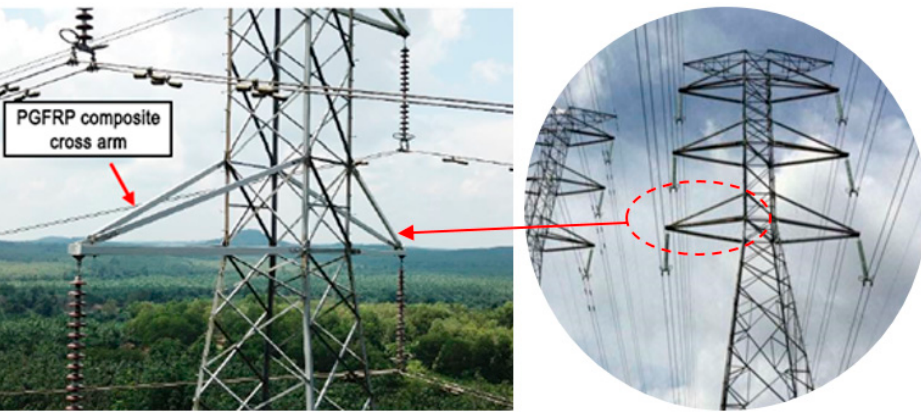
Figure 3. Dimension of latticed transmission tower.